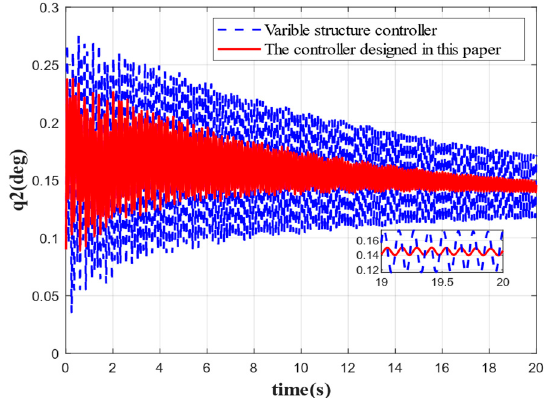
Figure 14. Second ‐ order elastic vibration mode with external interference.